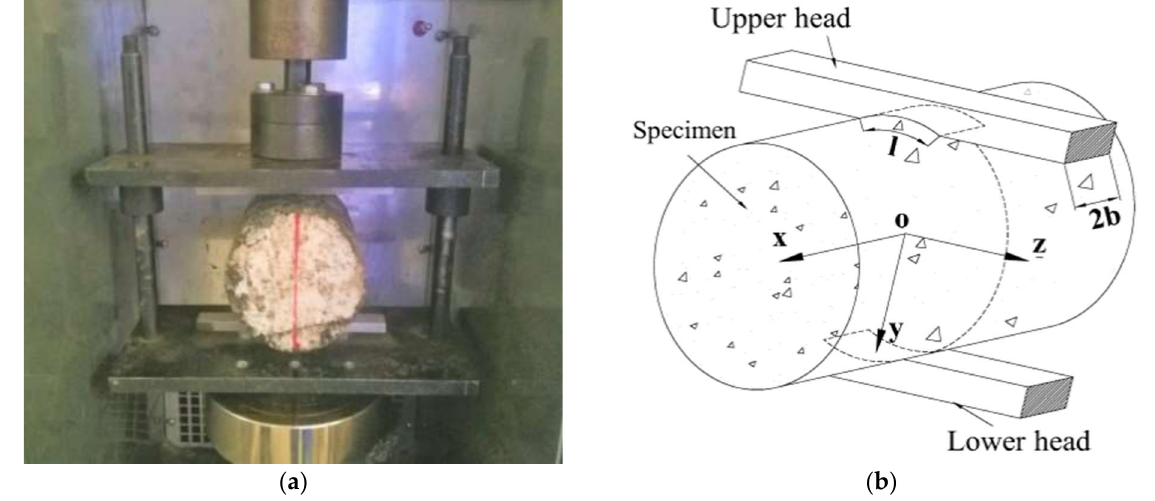
Figure 1. Test: ( a ) loading test; ( b ) loading model.